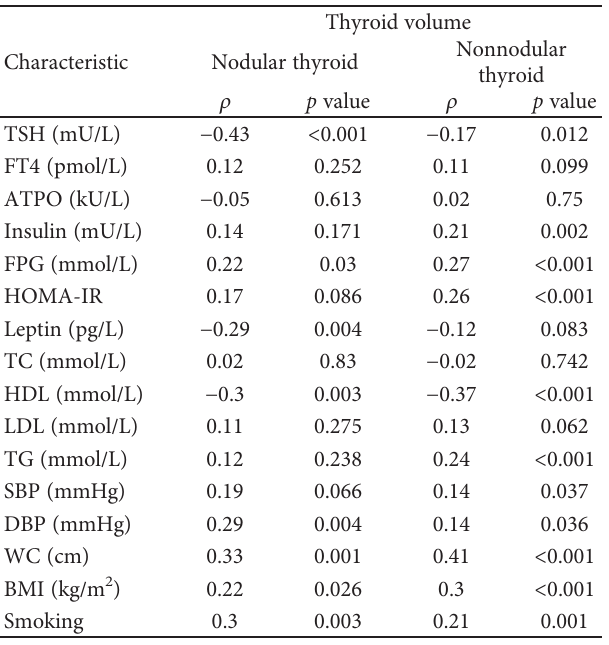
Table 2: Relationship between thyroid volume and di ff erent variables in subjects with and without thyroid